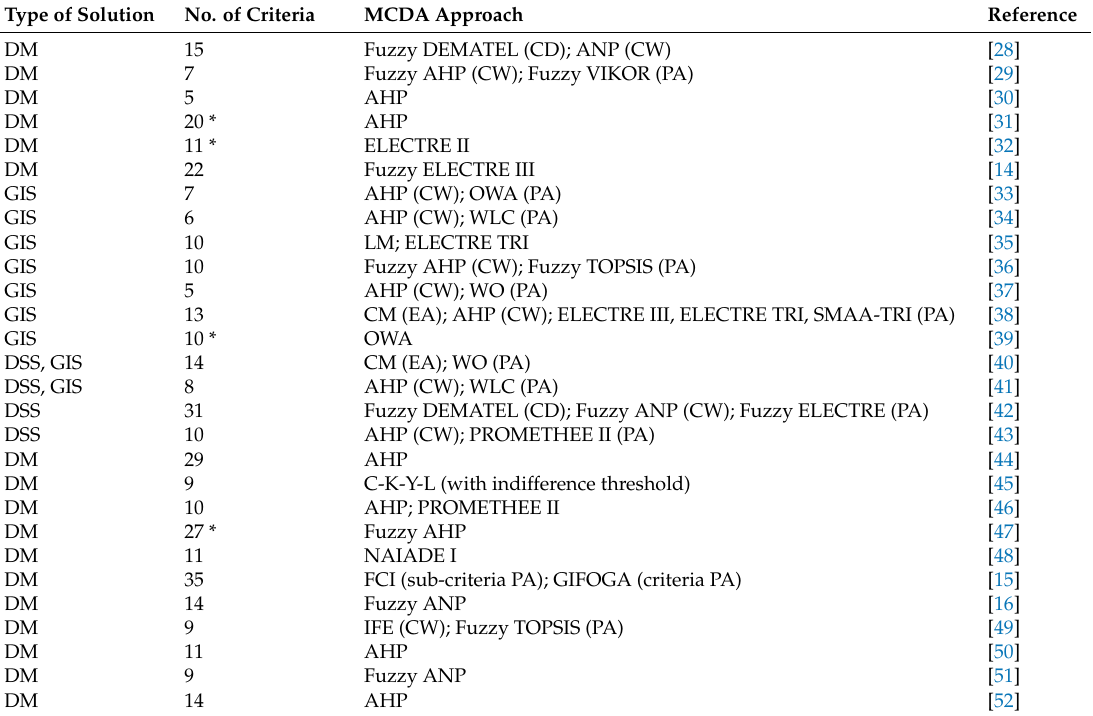
Table 2. The use of MCDA in decision support concerning wind